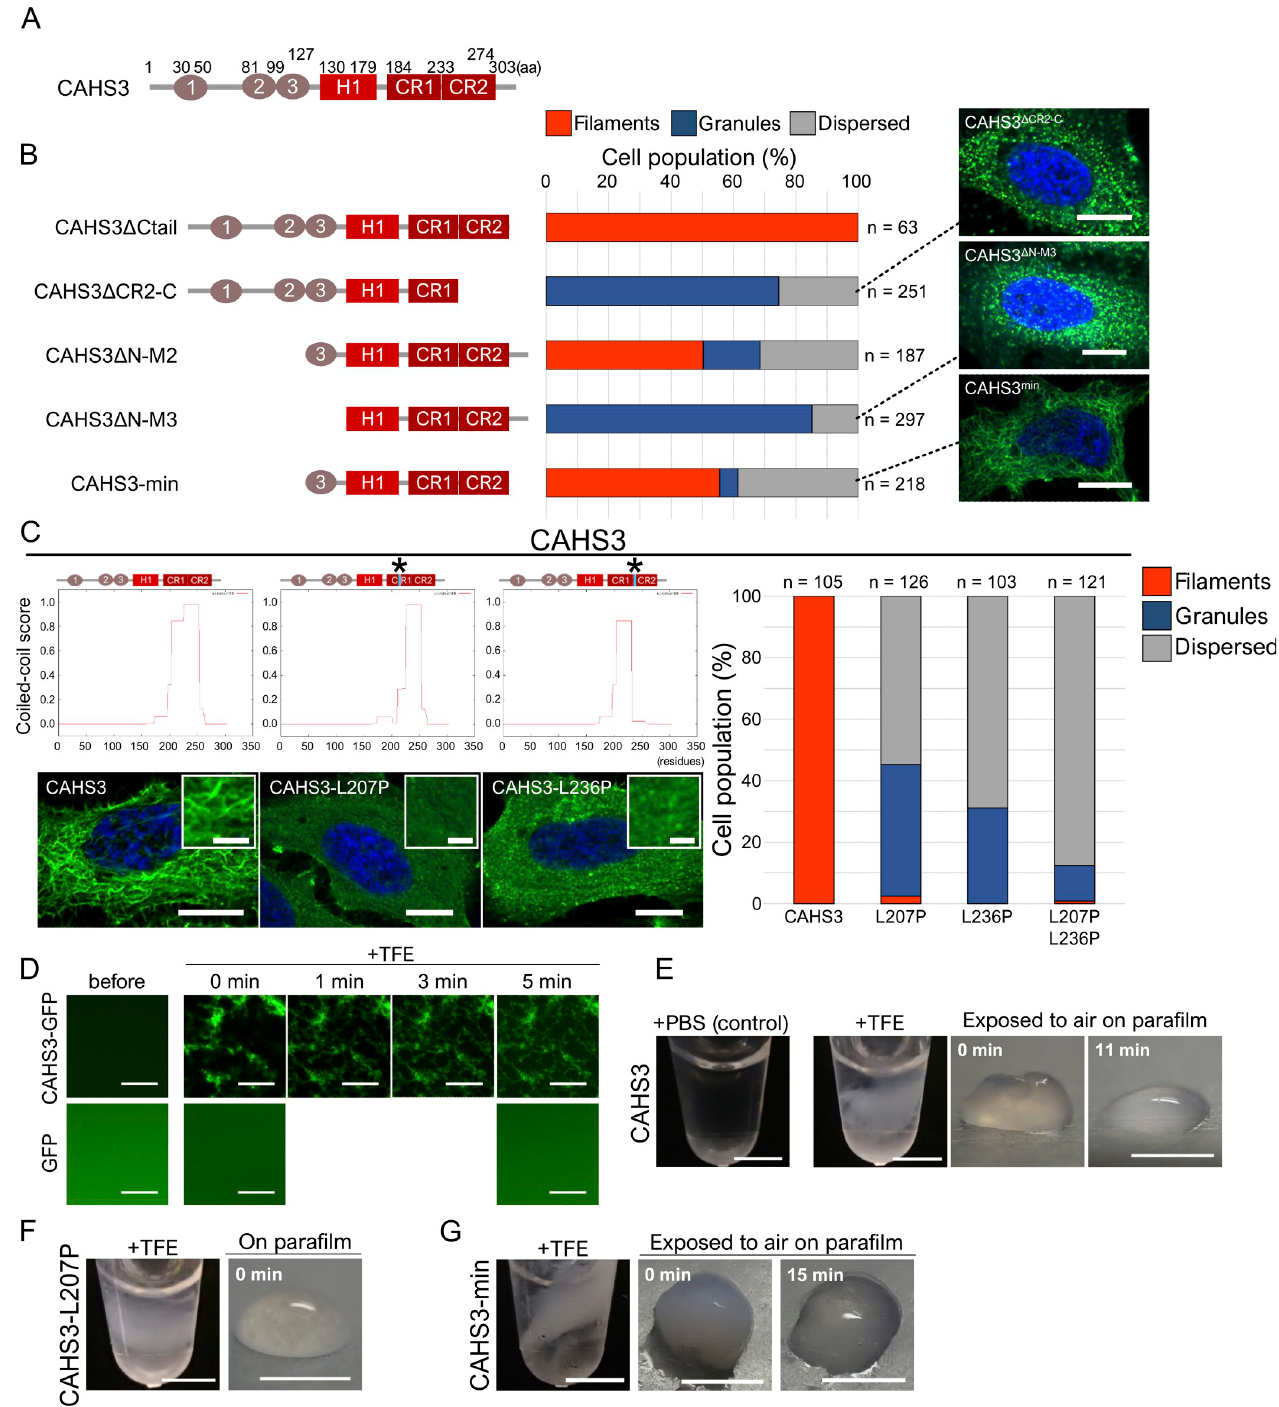
Fig 3. Secondary structure in the conserved C-terminal region is responsible for the CAHS filament formation and gelation. (A) Schematic diagrams of CAHS3 proteins. “CR1” and “CR2” indicate putative helical motifs highly conserved among almost all CAHS family members. “H1” indicate putative helical conserved motifs; “1,” “2,” and “3” indicate other conserved motifs. (B) Schematic diagrams and the corresponding distribution patterns of the truncated mutants of CAHS3. Quantified cell proportions of the distribution patterns under a hyperosmotic condition are shown as a stacked bar graph. Confocal images are shown for the representative distribution pattern of the corresponding CAHS mutants. Blue indicates Hoechst33342 staining of nuclei. (C) Effects of a helix-disrupting mutation by substituting leucine with proline on filament formation of CAHS3. Schematic structure and the coiled-coil score predicted by COILS are shown for both wild-type and proline substitution mutants. Asterisks indicate the sites of proline substitutions. Substitution with proline